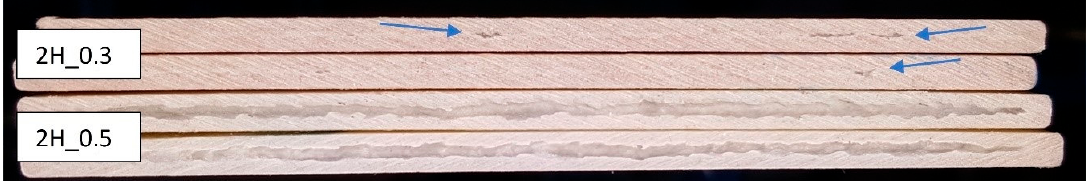
Figure 7. Composites made with closed-injection pultrusion (CIP) using teardrop ii_chamber at 0.3 m/min (two top profiles) and 0.5 m/min. dry spots are marked with arrows .